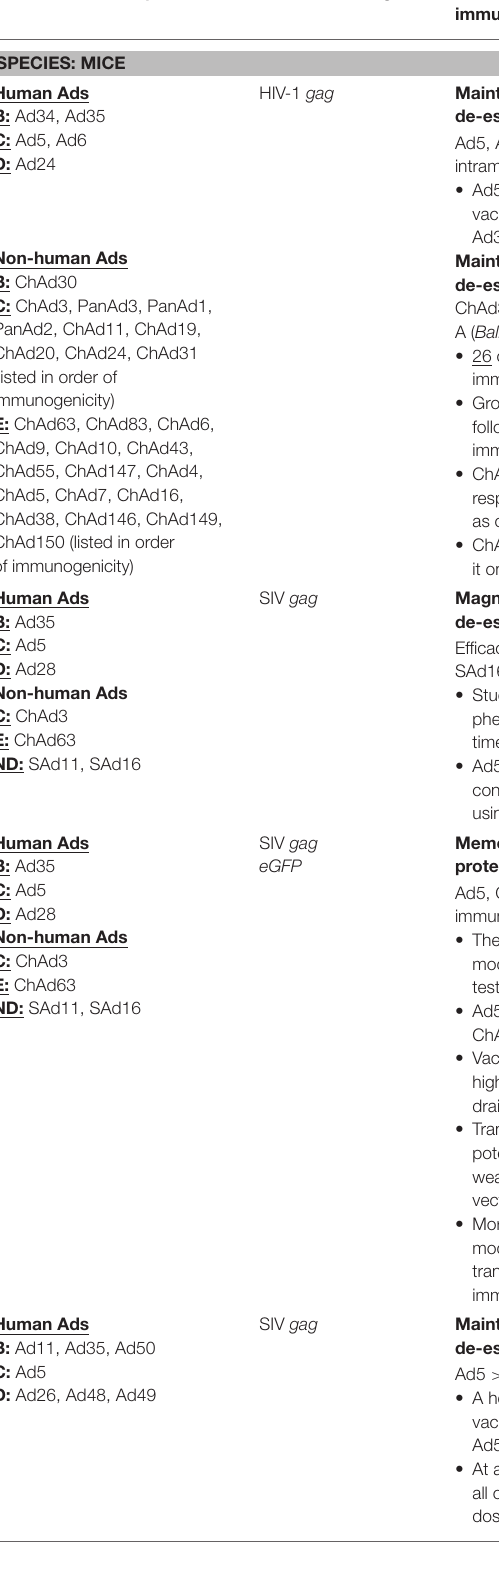
TABLE 2 | Summary of the comparative immunogenicity of diverse AdV vaccines. A. Ad vectors